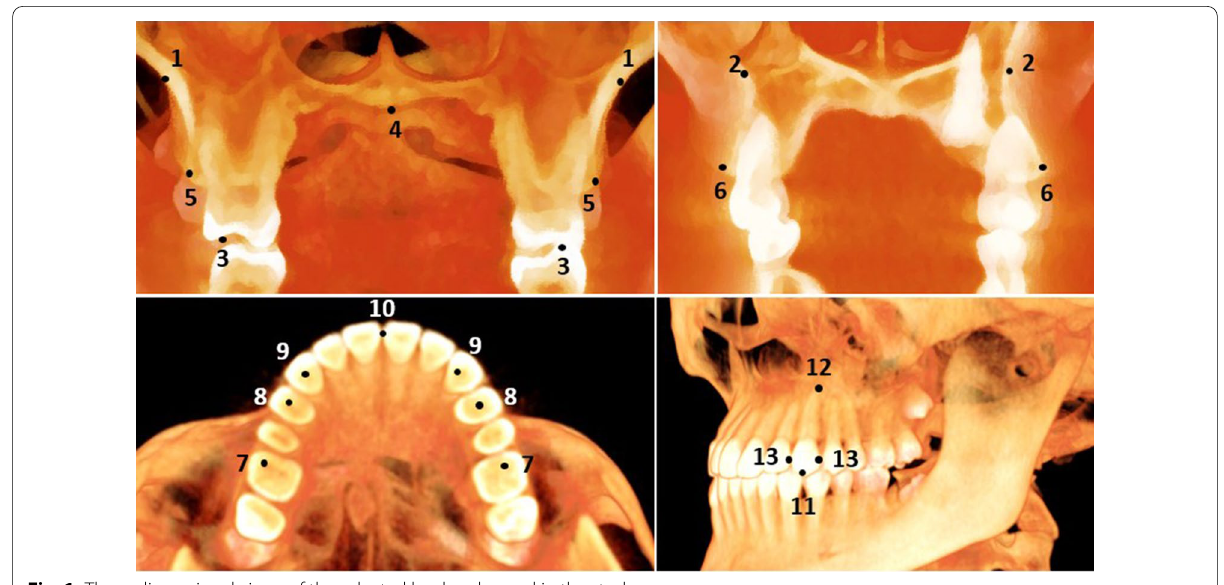
Fig. 1 Three‑dimensional views of the selected landmarks used in the study